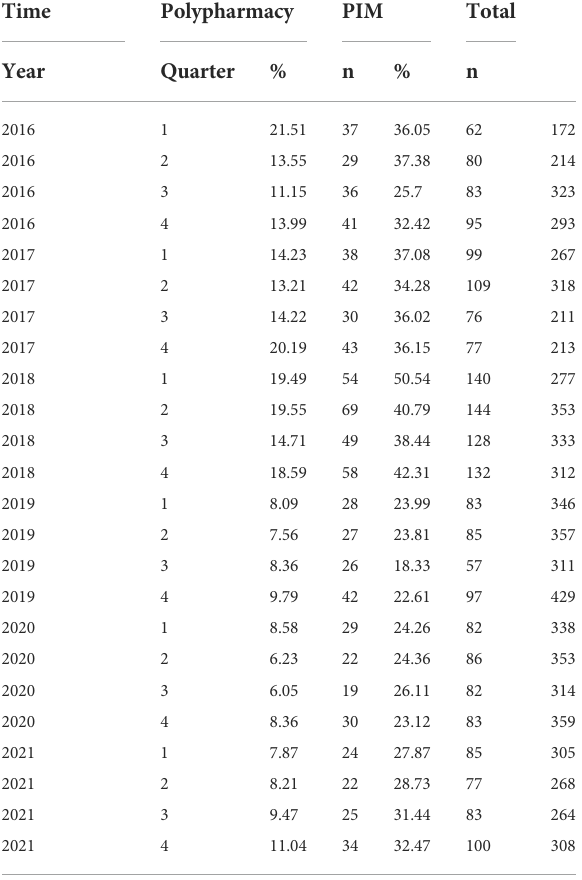
TABLE 1 The prevalence of polypharmacy and PIM use in elderly lung cancer outpatients with multimorbidity. Time Polypharmacy PIM Total